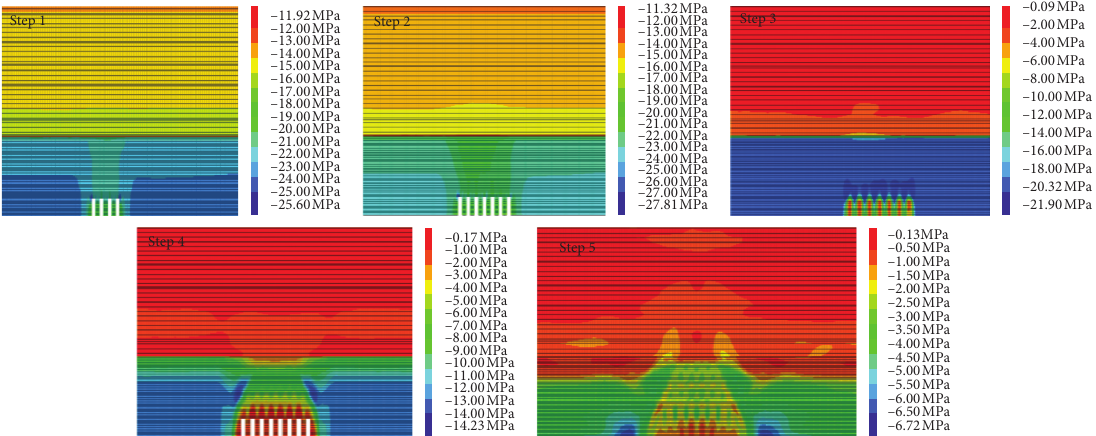
Figure 9: Stress transferring process of Scheme 2 (contour of maximum principal stress, X � 70m).